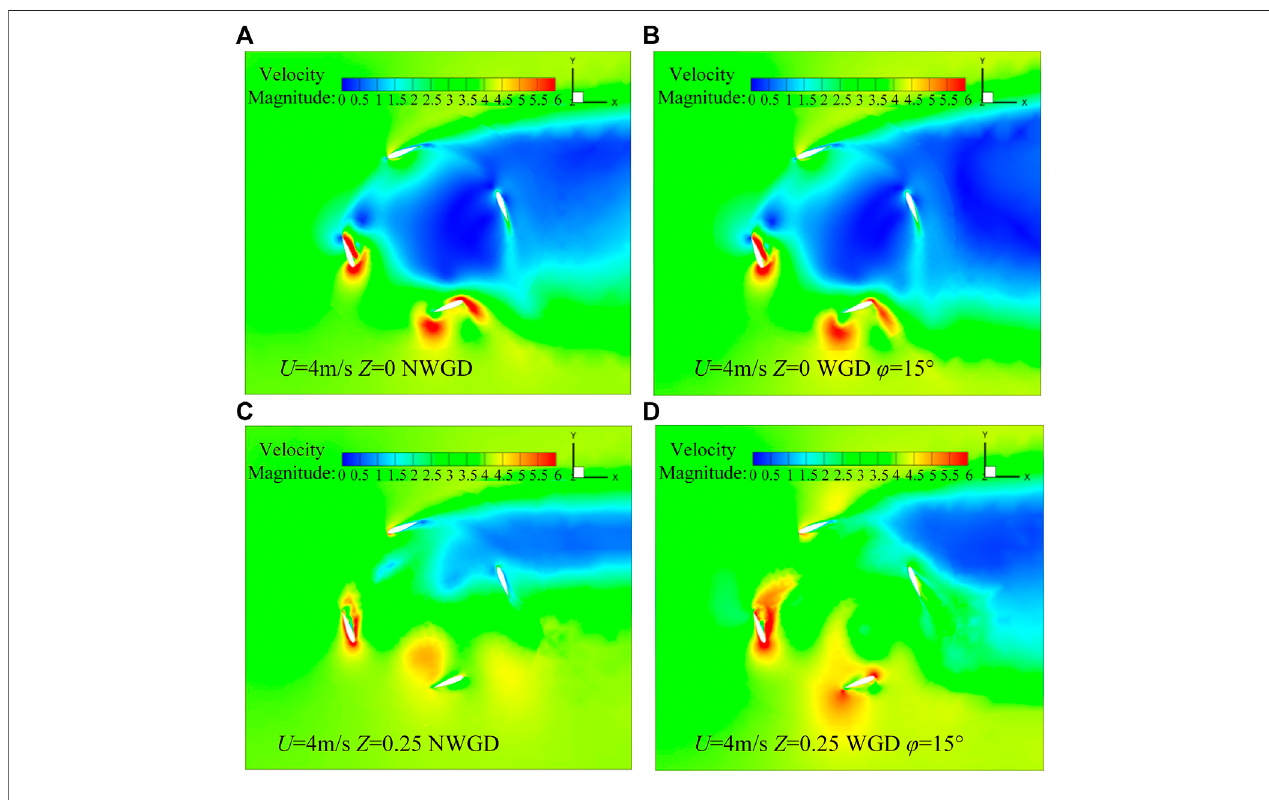
FIGURE 12 | Dynamic velocity